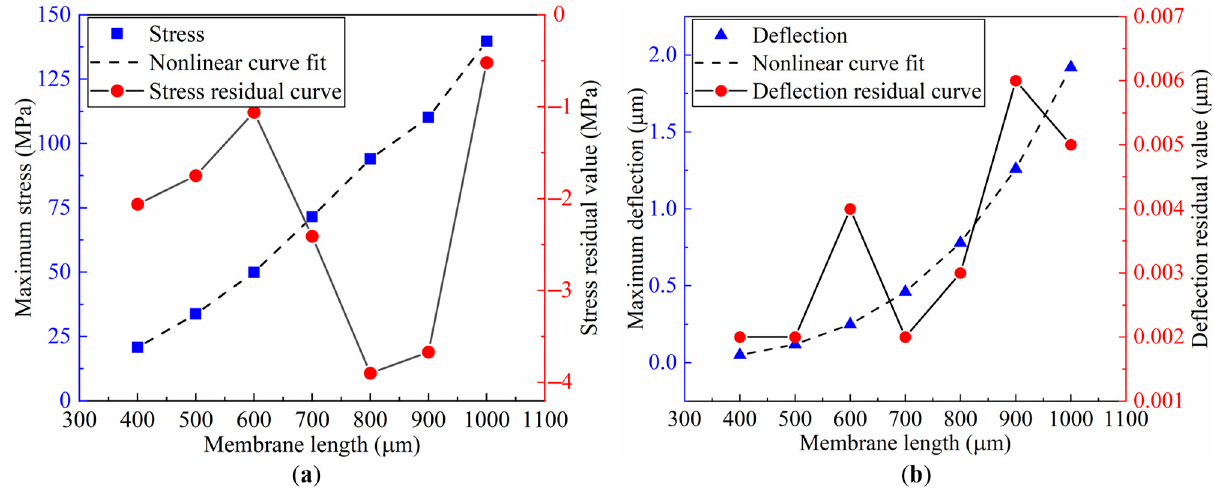
Figure 7. Membrane length variables versus mechanical performance variations: ( a ) maximum stress variation; and ( b ) maximum deflection variation.